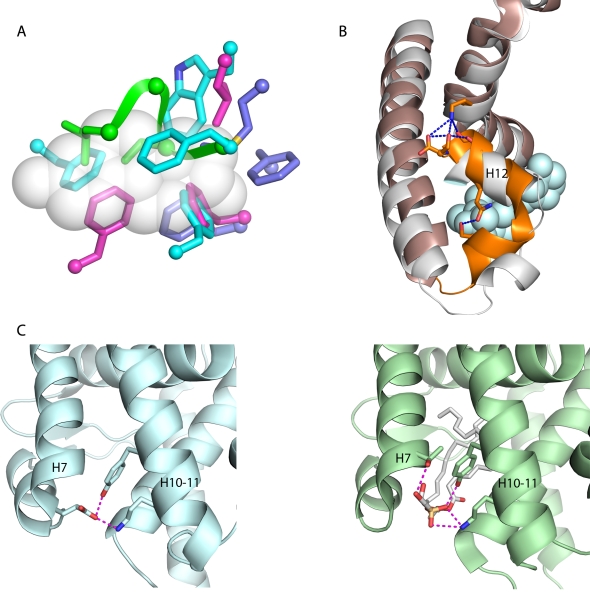
Independent structural mechanisms for ligand-independent activation in nuclear receptors.(A) Receptors with filled ligand cavities. Bulky side chains (shown as sticks) that fill the cavity are shown for rat Nurr1 (cyan), human ERRα (magenta), and oyster ER (blue), with α-carbons as balls. Green ribbon, backbone of the loop with side chains that fill the pocket in D. melanogaster Ftz-F1. The van der Waals space occupied by estradiol in human ERα is in white. (B) In human CAR (bronze), a network of hydrogen bonds (blue) stabilizes the activation-function helix H12 and a novel adjacent helix (orange). These interactions are absent from other NRs, such as the close paralog VDR (white), shown with its ligand vitamin D (blue spheres). (C) In the LRH-1 protein of rodents (left, blue), a salt bridge and hydrogen bond between side chains on helices 7 and 10 replaces similar interactions in human LRH-1 (right, green) between each helix and the ligand (white). The ligand-mediated interactions and the amino acids involved in human LRH-1 are also present in the closest NR paralog SF-1 [33]. For PDB identifiers, see Table S7.